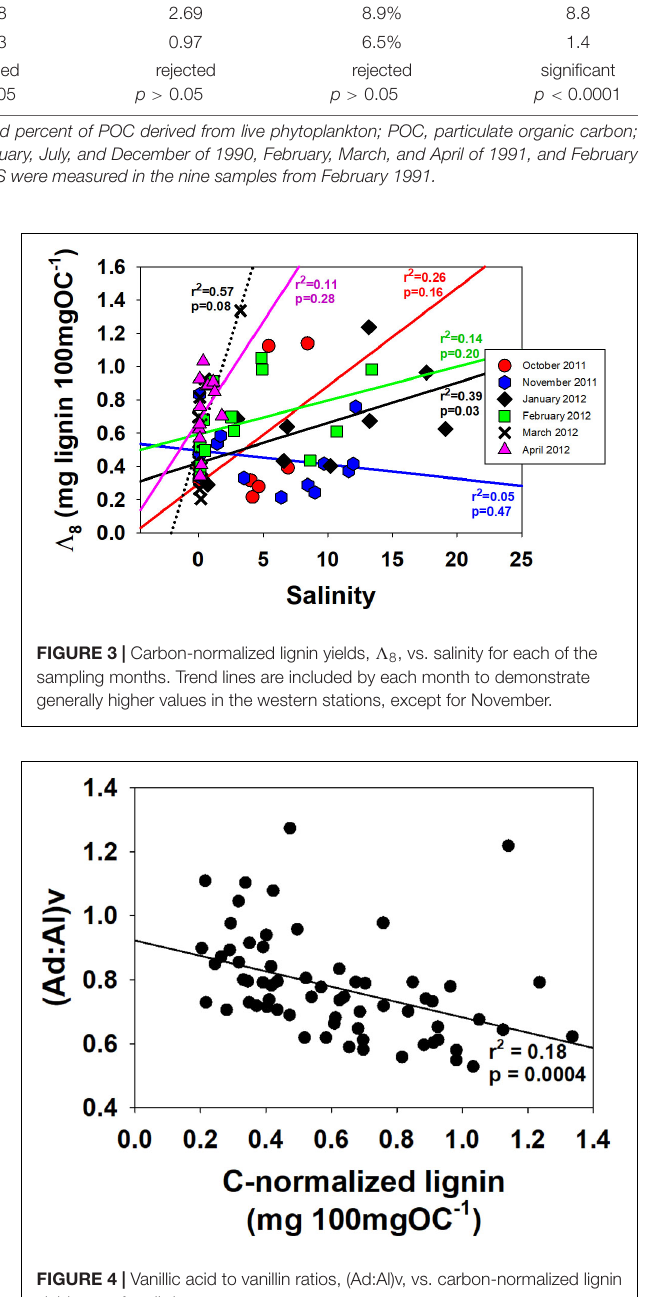
can reasonably be expected to correlate to (cid:51) 8 , i.e., fresh tissues from vascular plants have high C:N a and high lignin content. This is approximated by the Eel and Umpqua data ( Figure 5 ).